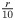
Parameters of the proposed foliage model.A) Expected value of the leaf radius r. The radii of all leaves are drawn independently from Gaussian distribution with mean r and standard deviation r10. Ten leaves are shown each for mean radii that equal 5, 15, and 20 mm, respectively. B) Leaf density ρ. Orthogonal projections on the xy-plane of a cubic volume (1 m3) filled with 5, 10, and 20 leaves are shown, respectively. The frame represents the borders of the cubic volume. C) Orientations in a leaf sample around mean orientation angles (α) of 0°, 45°, and 90°, respectively. The orientation angle is defined as the angle between leaf normal and the direction the sonar is aimed in, orientations are drawn from Gaussian distribution with mean α and a fixed standard deviation of 5°.